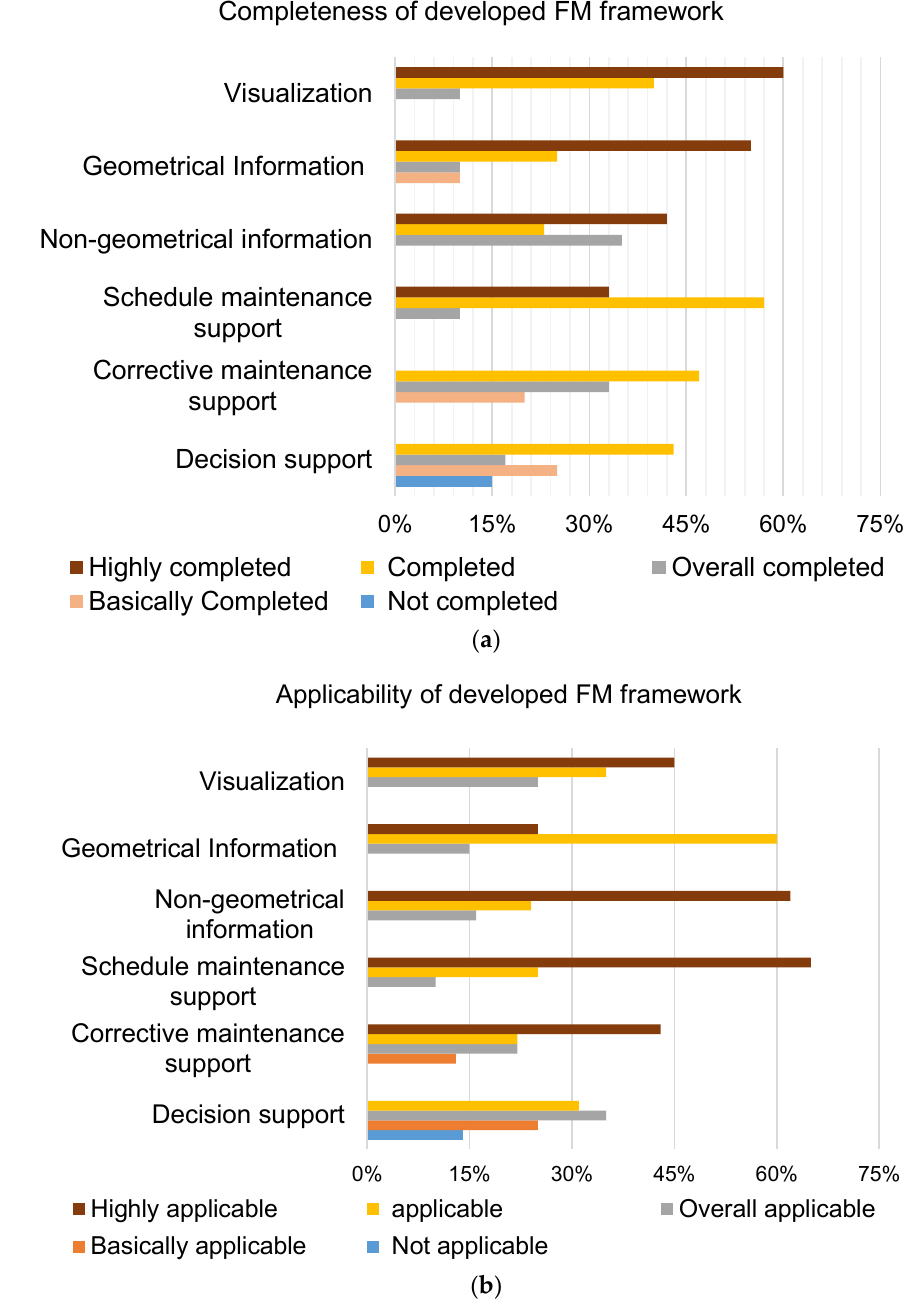
Figure 15. Users’ feedback; ( a ) completeness, and ( b ) applicability of the developed system